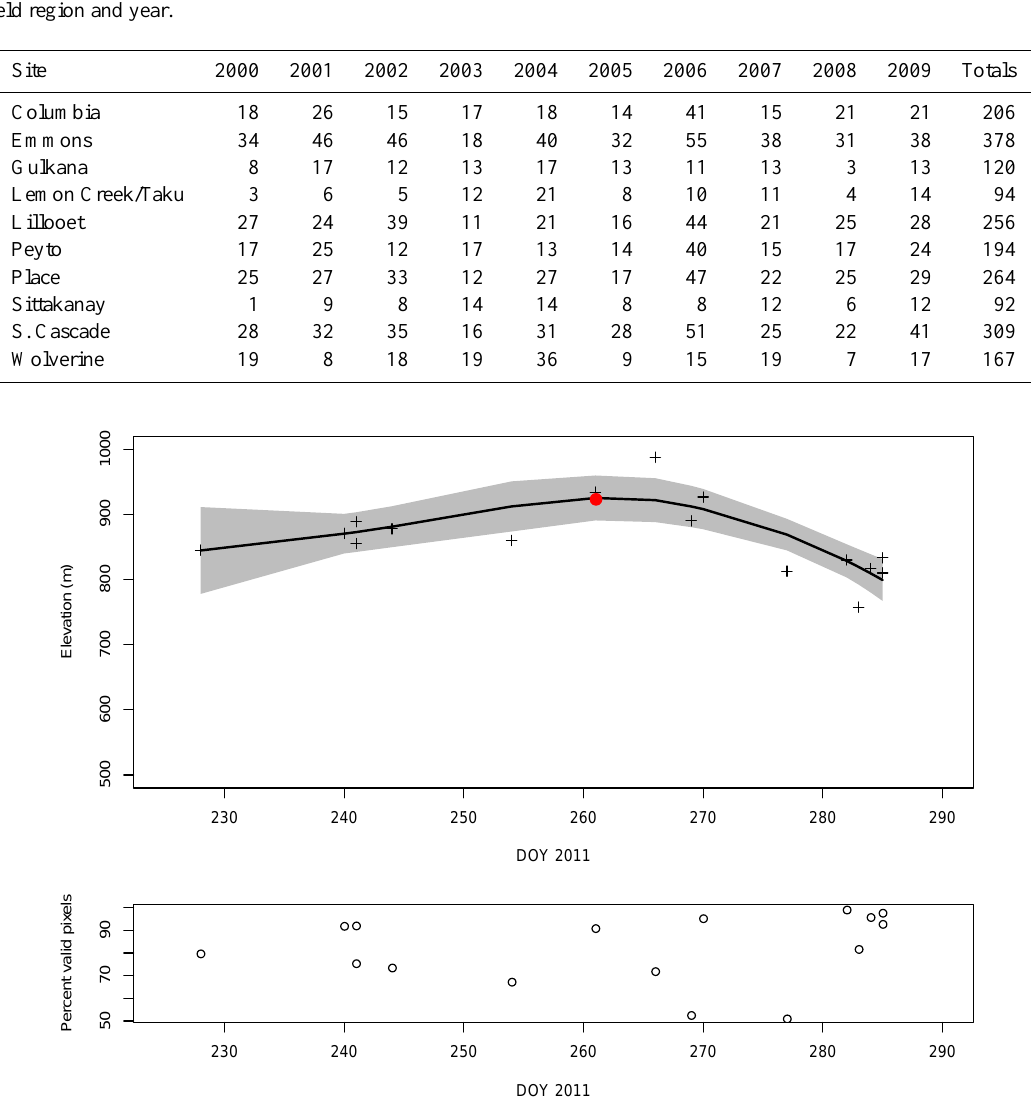
Table 2. Number of MOD02QKM scenes that meet criteria for time of acquisition, cloud cover, and snow extent thresholds for each index glacier/icefield region and year.